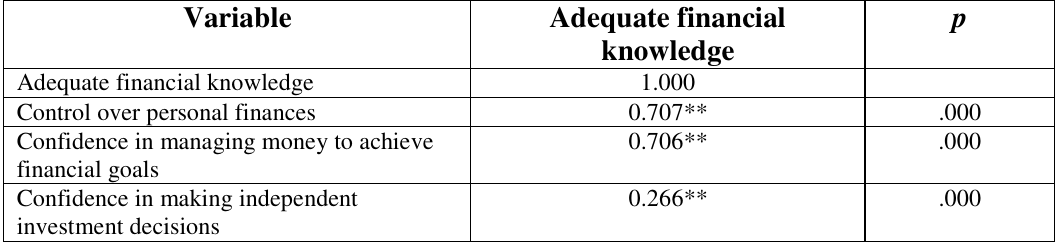
Table 2: Pearson Correlation coefficient between adequate financial knowledge and other variables (two-tailed) (N = 286)